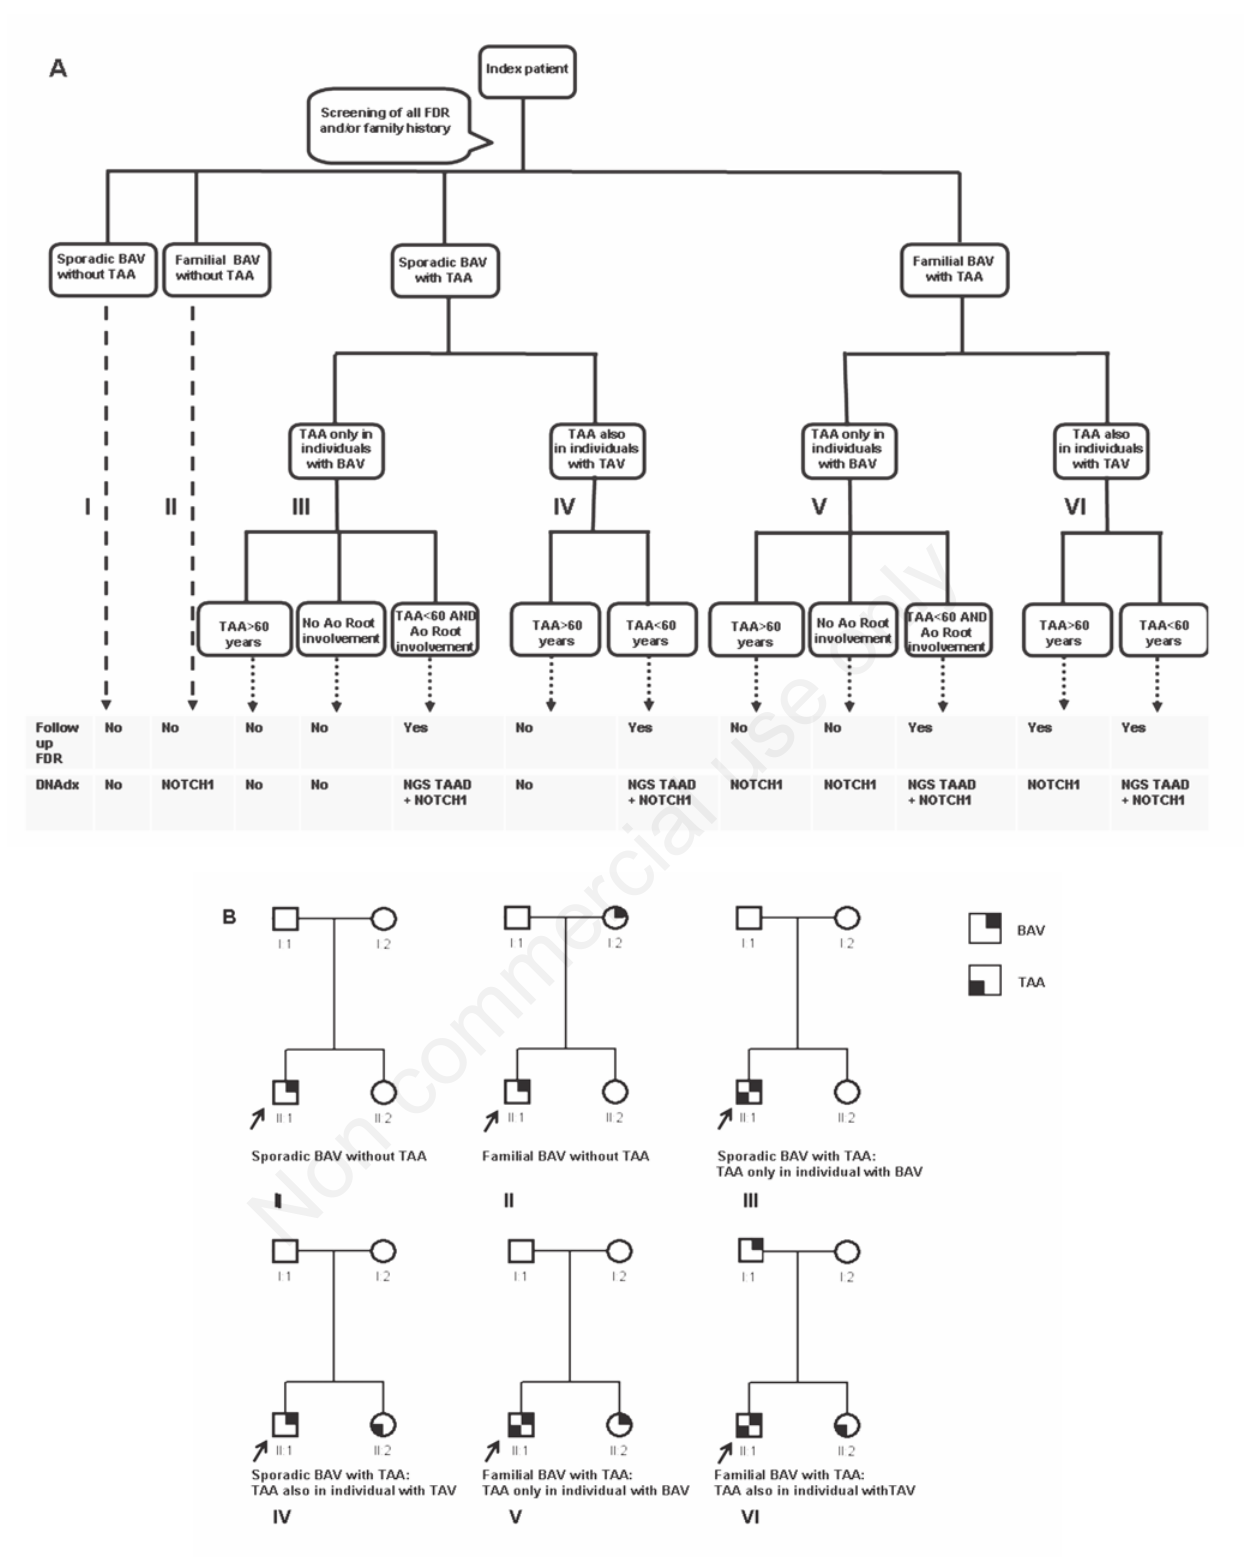
Figure 1. A) Flow chart illustrating a proposed model for genetic testing, and clinical work-up of first-degree relatives (FDR) of patients with bicuspid aortic valve (BAV). Clinical follow up of first-degree relatives comprises echocardiographic screening at a low frequency ( e.g. , every five years) starting at the age of 18 years. In our center NGS TAAD analysis includes: ACTA2, COL3A1, EFEMP2, ELN, FBN1, FBN2, MYH11, MYLK, PLOD1, SLC2A10, SMAD3, TGFBR1 and TGFBR2 . B) Simplified pedigrees illustrating examples of the different familial situations in the flow chart. Men are encoded with squares, women with circles. Index patients are indicated with an arrow. Ao root involvement, aortic root involvement; NGS, next generation sequencing; TAA, thoracic aortic aneurysm; TAV, tricus- pid aortic